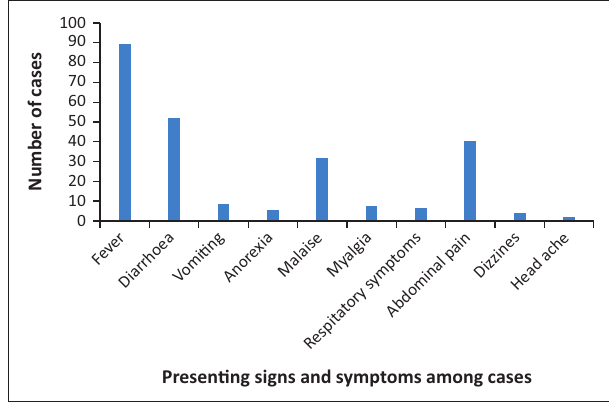
FIGURE 2: Presenting signs and symptoms amongst all cases, Sekhukhune District, Limpopo province, November – December